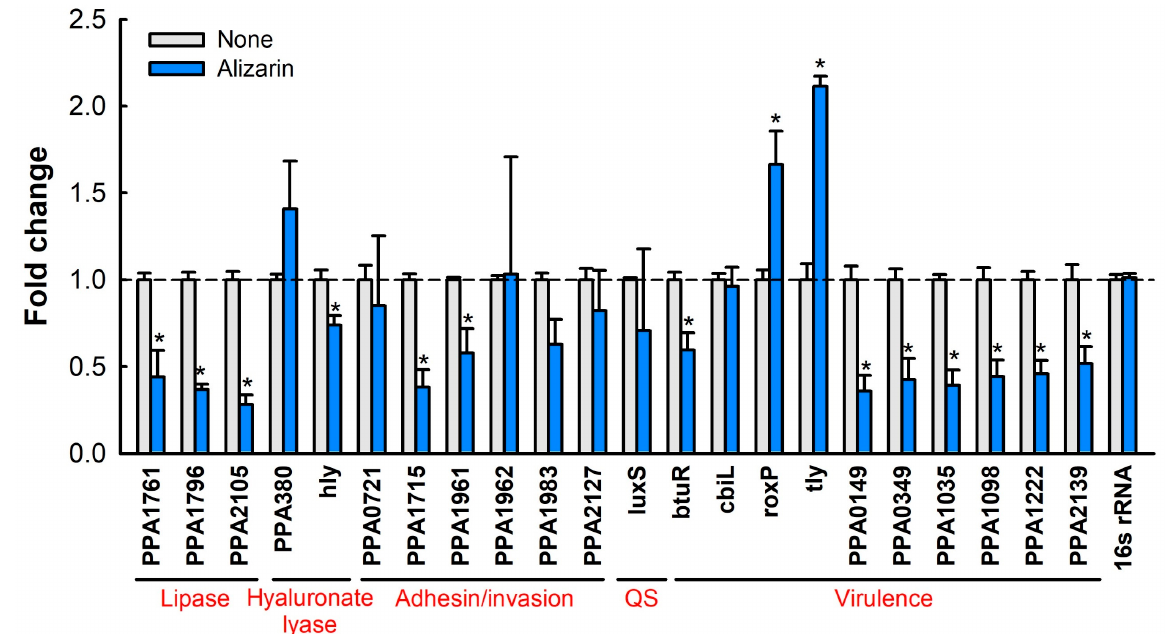
Figure 6. Relative gene expression profiles in C. acnes cells treated with alizarin. C. acnes cells were treated with alizarin at 10 µg/mL for 7 days without shaking. Fold changes indicate transcriptional differences observed in treated vs. untreated C. acnes (None) using qRT-PCR. QS indicates quorum sensing. Detailed information of genes is present in Table S1. The experiment was assessed in duplicate (six qRT-PCR reactions were assessed per gene). * p < 0.05 vs. non-treated controls (None).